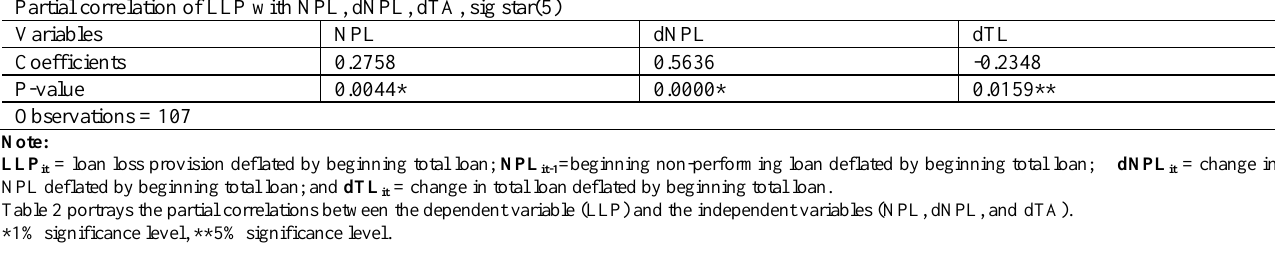
Table 2: Partial correlations (equation 1) Partial correlation of LLP with NPL, dNPL, dTA, sig star(5)